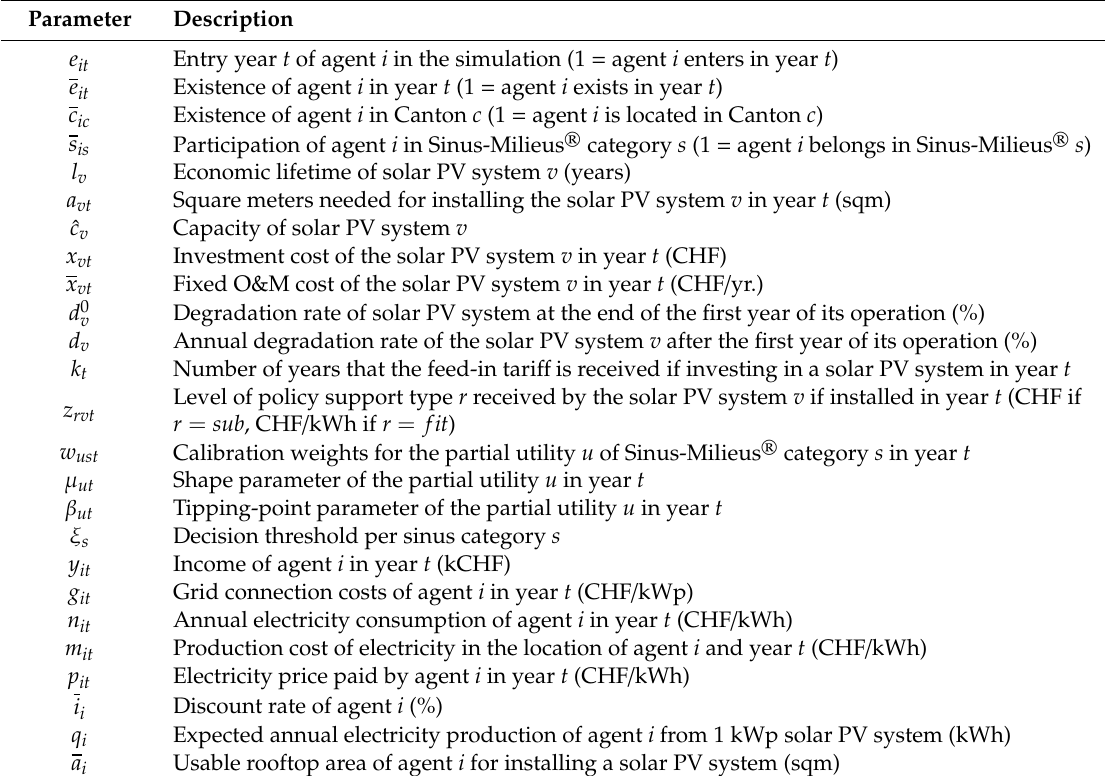
Table A9. Parameters used in the mathematical description of the model.